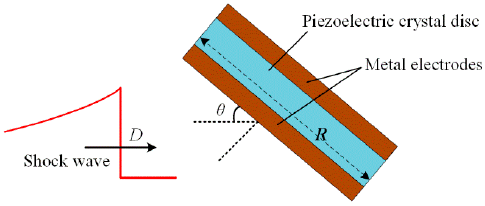
Figure 5. Sensitive element of a piezoelectric probe.